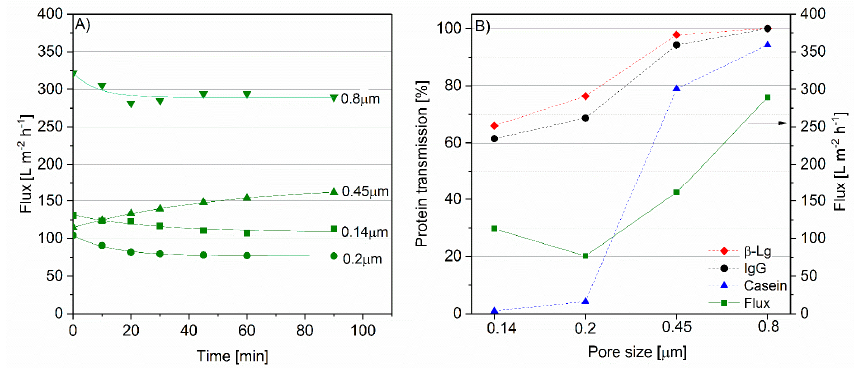
Figure 2. Flux (green) as a function of the time at different pore sizes ( A ), IgG, β -Lg, casein transmission plus flux as a function of pore size at steady state conditions after 90 min of filtration ( B ) (gradient membrane, 50 °C). Arrow indicates the belonging of the flux curve to the right y-axis.